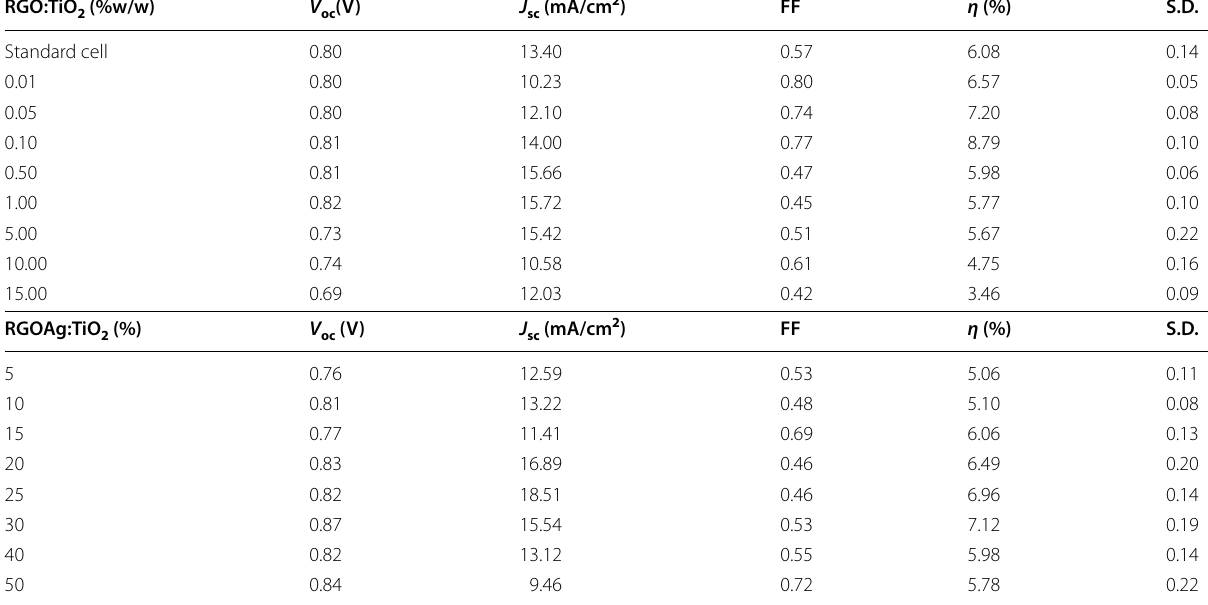
Table 2 Photovoltaic parameters of the difference PEs in DSSCs RGO:TiO 2 (%w/w) V oc (V) J sc (mA/cm 2 ) Standard